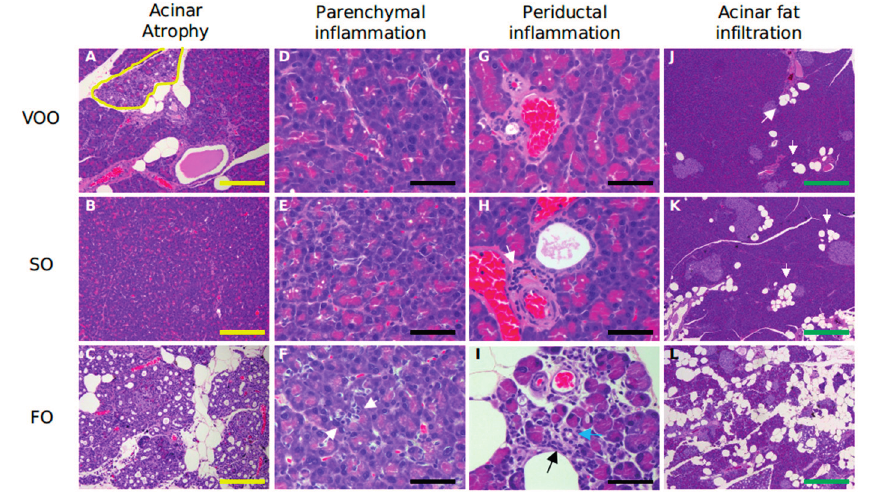
Figure 1. Histological sections of pancreas from rats fed on different dietary fat sources supplemented with Coenzyme Q: virgin olive (VOO), sunflower (SO) and fish oil (FO) after hematoxilin and eosin staining for assessment of acinar atrophy, parenchymal and periductal inflammation and acinar fat infiltration, respectively. ( A ) Minimal acinar atrophy (indicated by a yellow circle); ( B ) Normal pancreatic tissues; ( C ) Severe acinar atrophy, grade 4; ( D , E ) Absence of inflammation; ( F ) Inflammatory cells (its presence is indicated by white arrows); ( G ) Absence of inflammation; ( H ) Minimal inflammation with some inflammatory cells (indicated by a white arrow); ( I ) More severe infiltrate (indicated by a black arrow) around the duct (indicated by a blue arrow); ( J , K ) Very low number of fatty cells and aggregates (grade 1–2) (indicated by white arrows); ( L ) Severe fat deposits (grade 3–4). Yellow bar = 200 μ m; Black bar = 50 μ m; Green bar = 500 μ